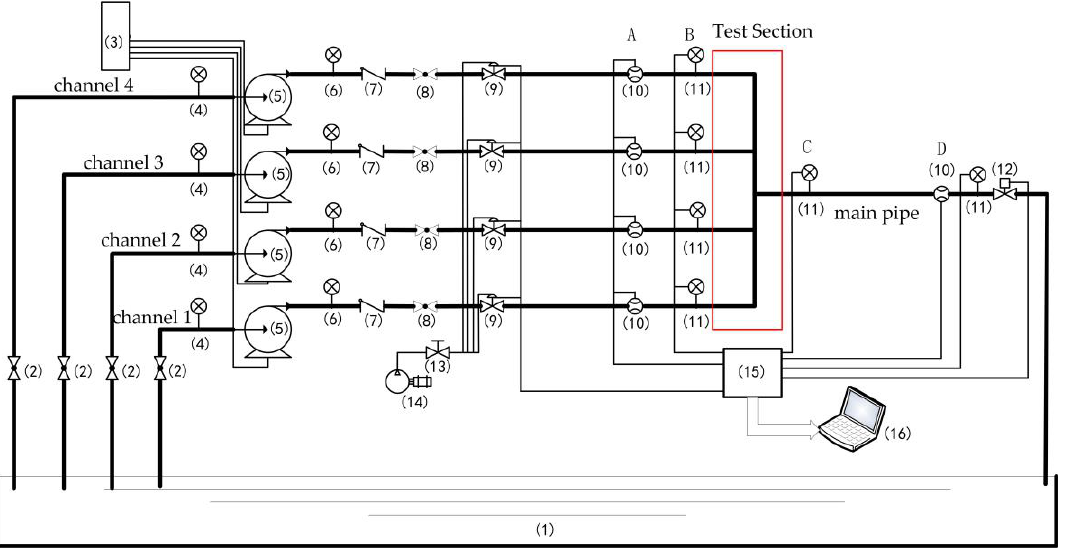
Figure 2. Schematic of the test setup and connections: (1) water tank; (2) hand valve; (3) frequency